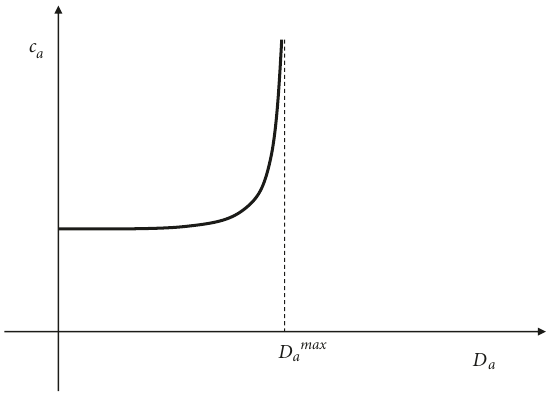
Figure 3: Density-delay relationship on road